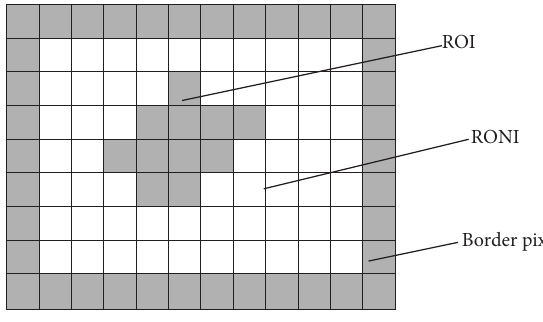
Figure 1: Division of medical image into three regions.